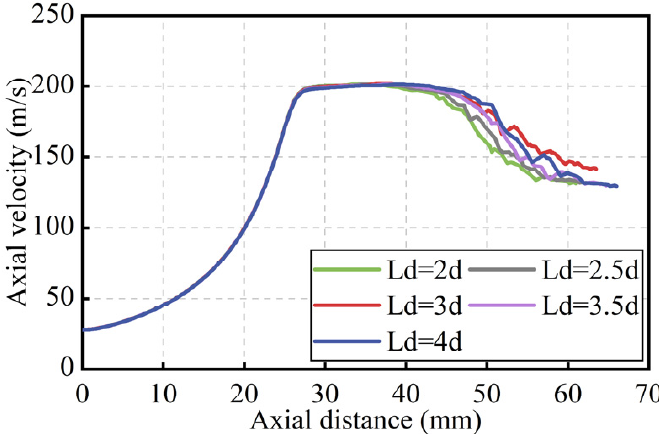
Figure 18. Effect of Ld on the fluid velocity.